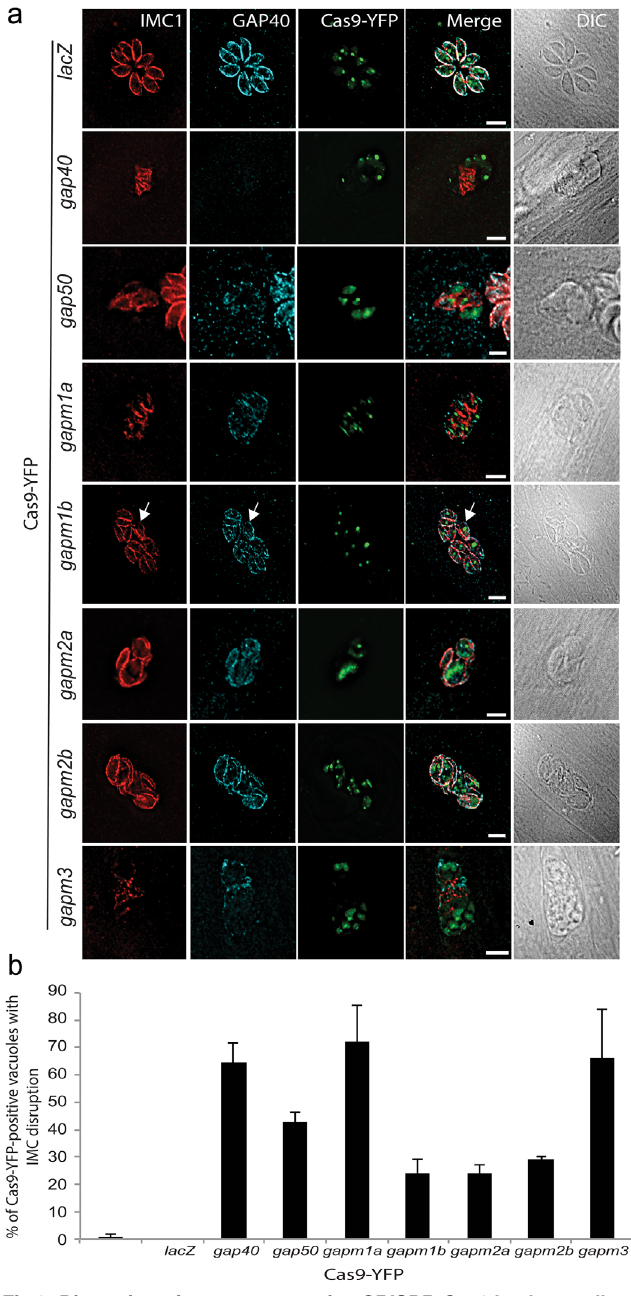
Fig 9. Disruption of gapm genes using CRISPR-Cas9 leads to collapse of the IMC Parasites were co- transfected with Cas9-GFP and gRNA targeted to indicated genes. ( a ) At 48 h post transfection, parasites were fixed and visualized using anti-IMC1 and anti-GAP40 antibodies. Parasites transfected with sgRNA targeting gap40 showed collapse of the IMC and an absence of GAP40 staining, while disruption of gap50 also resulted in structural collapse, confirming the utility of this technique. Disruption of gapm genes resulted in morphological abnormalities to varying degrees, suggesting that gapm1a and gapm3 are essential while disruption of gapm1b had a more subtle effect on parasite morphology. Scale bar 5 μ m. ( b ). Quantification of percentage of vacuoles positive for Cas9-GFP that showed disruption of the IMC at 48 h post transfection. While between 60 – 70% of GFP-positive vacuoles showed disruption to the IMC upon co- transfection with Cas9-GFP and gap40 , gapm1a and gapm3 , less than 30% of vacuoles co-transfected with gapm1b , gapm2a and gapm2b demonstrated severe phenotypes. Results average of three independent experiments, performed in duplicate ± standard